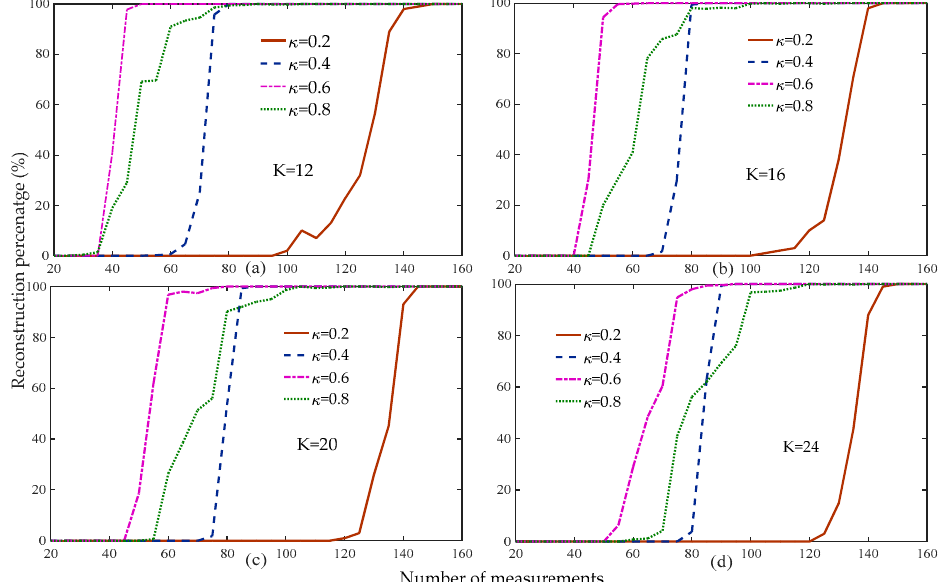
Sensors 2019 , 19 , x FOR PEER REVIEW 12 of 23 when the threshold was 0.8, followed by 0.6, with very small differences between the two. Based on Figure 3. Reconstruction percentage of the proposed method at di ff erent weak selection thresholds Figure 3. Reconstruction percentage of the proposed method at different weak selection thresholds ( ( n = 256, K = 12,16,20,24, κ = 0.2,0.4,0.6,0.8, m = 20 : 5 : 160, Gaussian signal). n = 256 ,